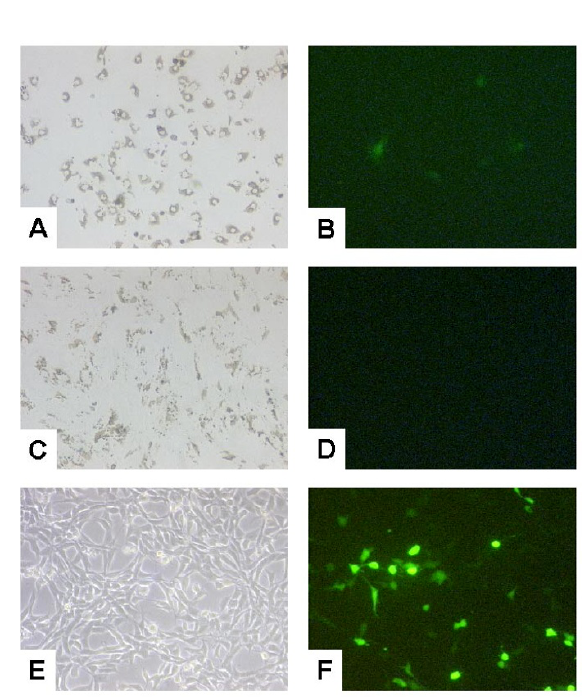
Figure 1 Representative analysis of transfection efficiencies of rat hepatic stellate cells and myofibroblasts using FuGENE™6 transfection procedure. Rat hepatic stel- late cells (rHSCs) were isolated from adult male Sprague- Dawley rats by the pronase-collagenase method and a single- step density gradient centrifugation. Rat myofibroblasts (rMFBs) were prepared by subculturing primary rHSCs by trypsinization at day 7 after seeding following spontaneous activation on a plastic surface. The established murine cell line NIH/3T3 served as a reporter transfection cell line. Cells were transfected with 2 µ g of reporter construct pEGFP-C1 and FuGENE™6 according to the suppliers instructions. After incubation for proposed time media were changed and transfection efficiencies were monitored 48 hours after transfection. Representative phase contrast microscopy (A, C, E) and fluorescence microscopy (B, D, F) of rHSCs (A, B) , rMFBs (C, D) and NIH/3T3 cells (E, F) are shown. The intensity of fluorescence varies among transfected cells indi- cating various levels of reporter expression. flow cytometric analysis revealed that the non viable rHSC were negative for EGFP. The fraction of about 11% dead rHSC may be due to destructive effects of trypsini- zation and washing procedures on these fragile cells.